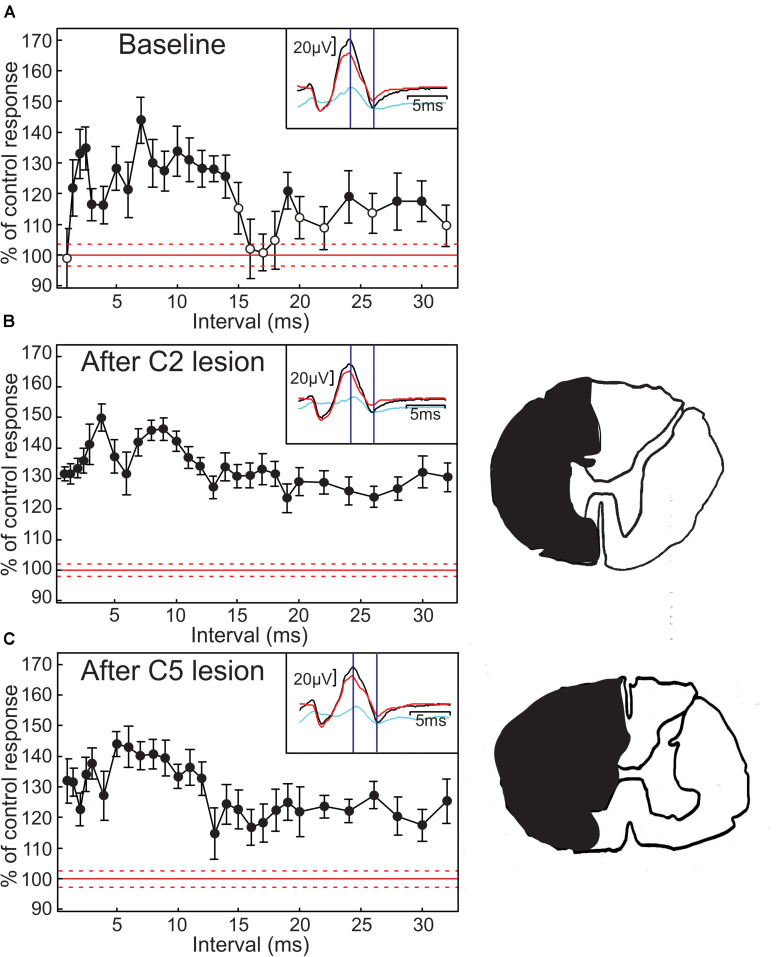
Modulation of H reflexes in anesthetized monkey. (A) modulation of H reflex as a function of condition-test interval. Reflex size is expressed as a percentage of the response following test stimulus alone. Error bars indicate SEM; filled symbols mark points significantly different from 100% (P < 0.05). Red line indicates the 100% level, with dotted lines marking the SEM of the test reflex size. Insets show responses to test only (red) and conditioned at an interval of 7 ms (black), with the difference between these responses plotted in light blue. Vertical lines indicate latencies used to measure H reflex amplitude. Test stimulus 1.87× motor threshold (MT), conditioning stimulus 0.6× MT. (B) H reflex facilitation profile, after ipsilateral hemisection at C2. (C) The same after ipsilateral C5 hemisection. Drawings on the right are traced from a photograph at the largest extent of the lesion in each case, indicating the region destroyed in black.